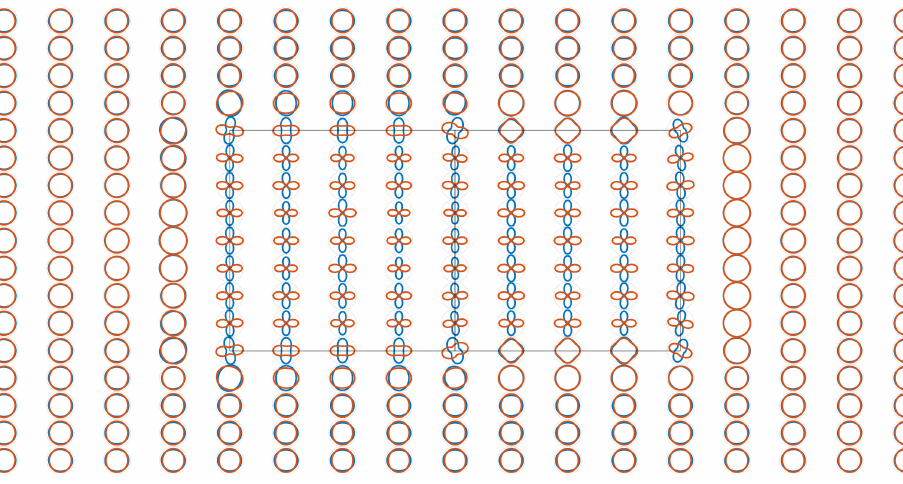
Figure 21. Polar plots of modified COMMEMI 3D-2A model for a frequency of 0.1 Hz.